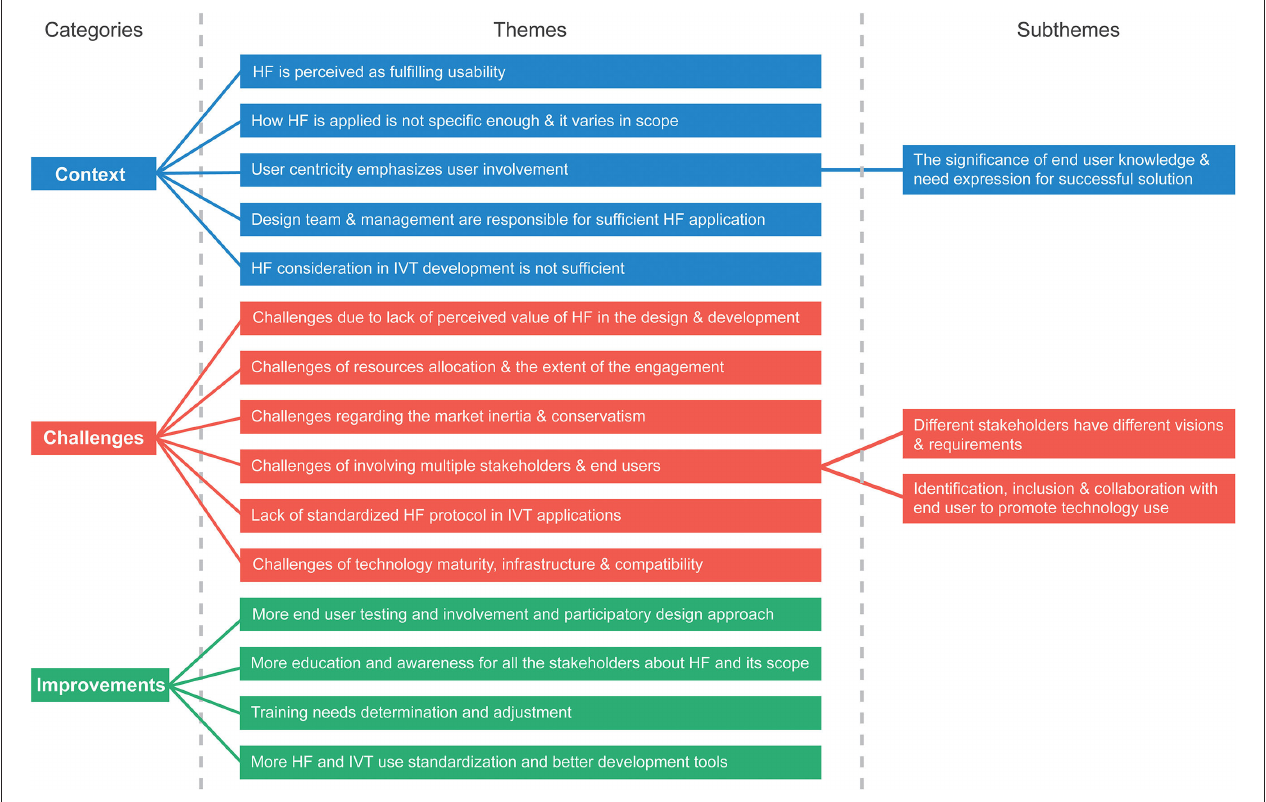
FIGURE 2 | An overview of categories and their respective themes and subthemes.